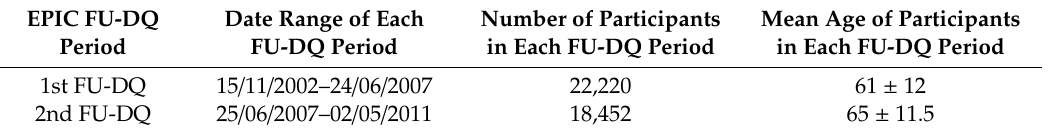
Table 1. Participation in each follow-up dietary questionnaire FU-DQ period.